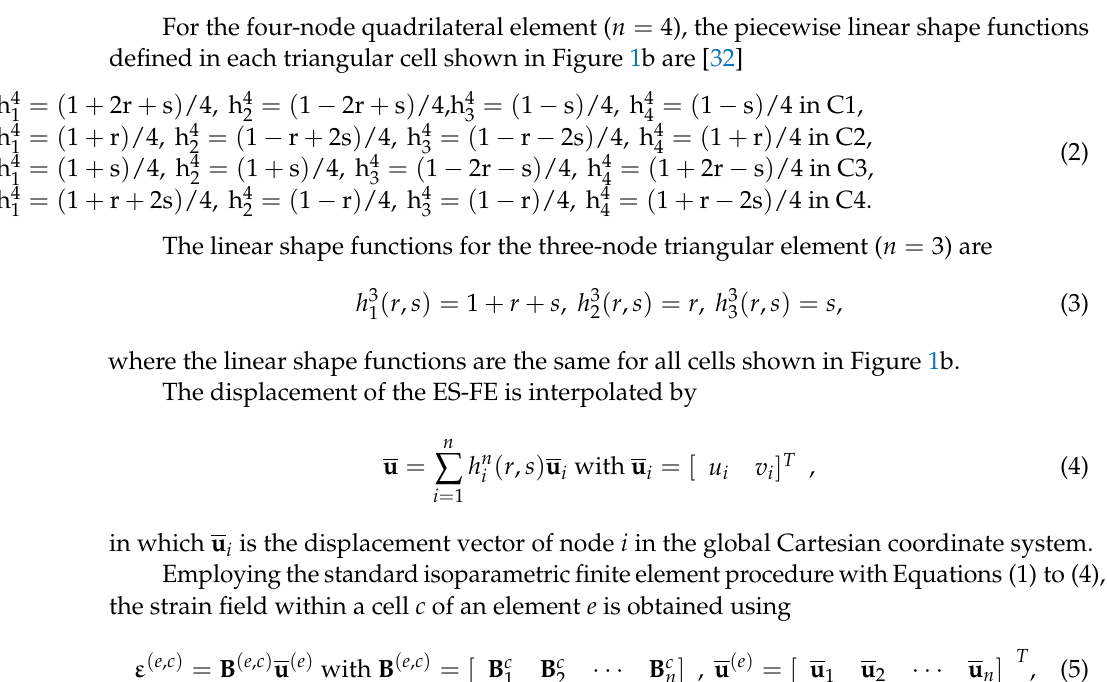
Figure 1. Coordinate systems for a 2D solid finite element: ( a ) Global Cartesian coordinate system ( x , y ) , and nodal local coordinate systems ( ξ i , η i ) , and ( b ) natural coordinate system ( r , s ) .